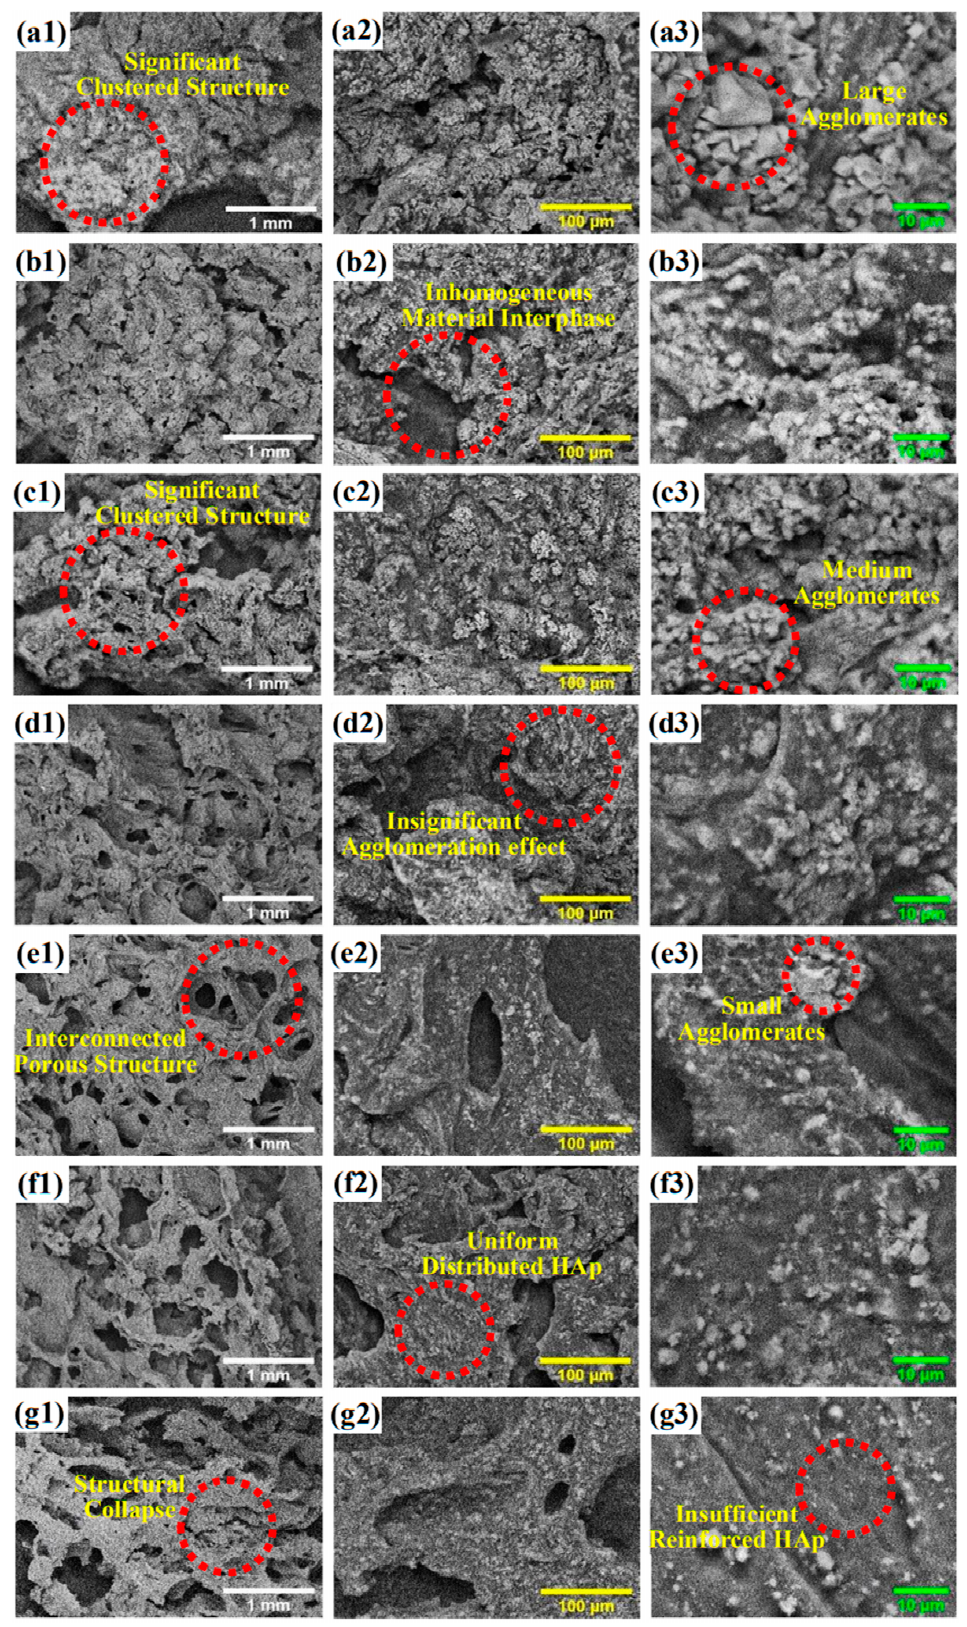
Figure 1. Morphological features of synthesized porous composites: ST30 ( a1 – a3 ), ST40 ( b1 – b3 ), ST50 ( c1 – c3 ), ST60 ( d1 – d3 ), ST70 ( e1 – e3 ), ST80 ( f1 – f3 ), and ST90 ( g1 – g3 ).